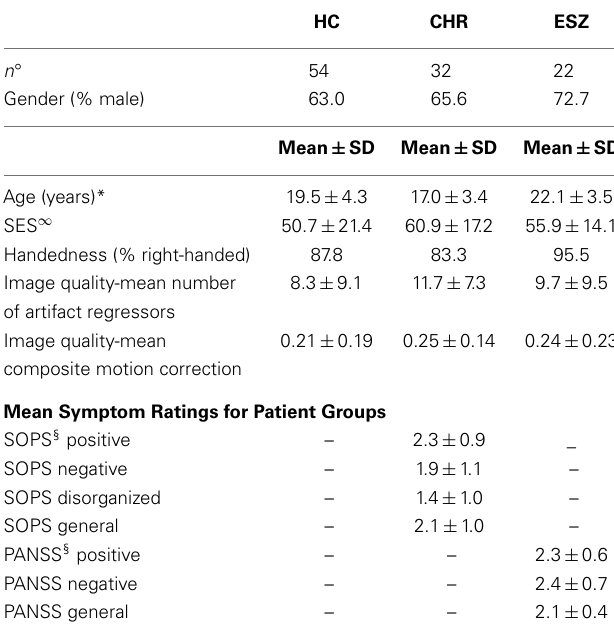
Table 1 | Demographic, image quality, and clinical data for participants in the healthy control (HC), clinical high risk for psychosis (CHR), and early illness schizophrenia (ESZ)